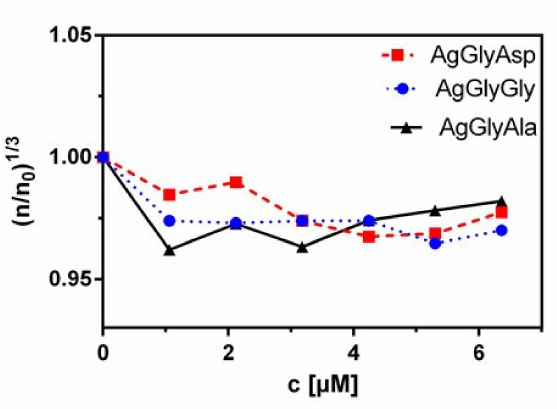
Figure 13. Effect of increasing amounts of silver(I) dipeptide complexes on the viscosity of CT DNA in 10 mM Tris buffer.